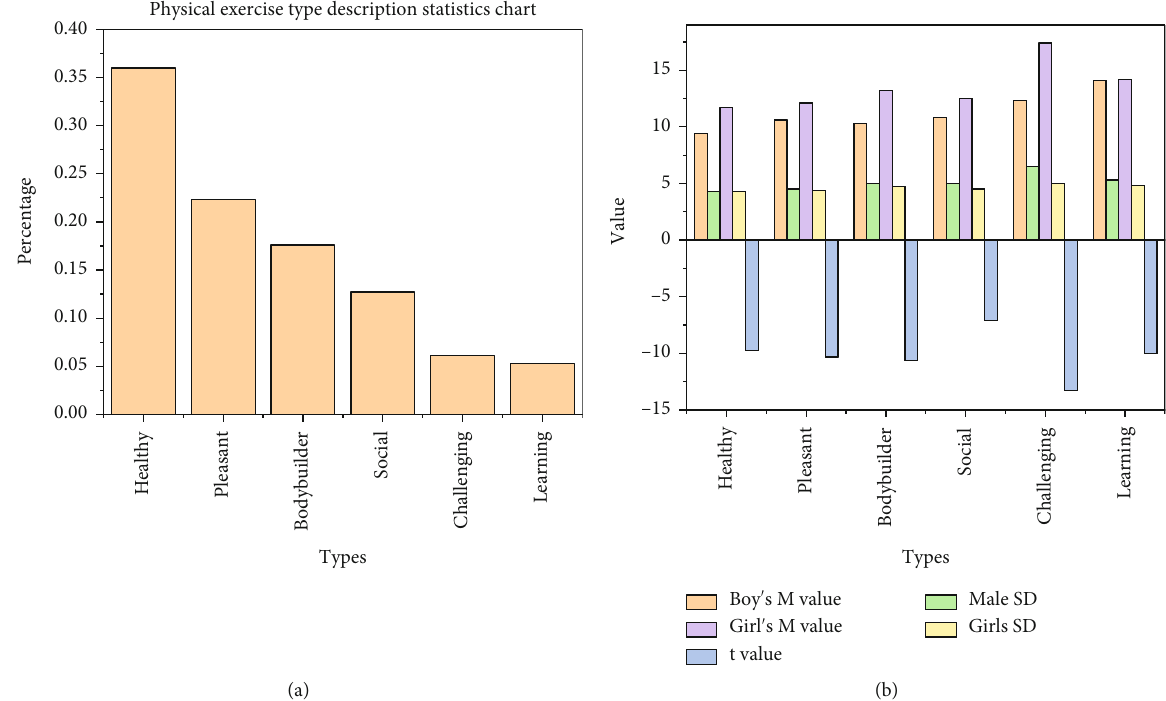
Figure 1: Physical exercise motivation and gender di ff erences ((a) physical exercise type di ff erences; (b) gender di ff